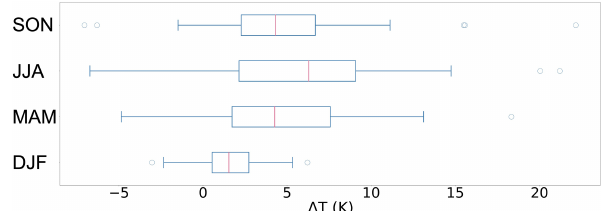
Figure 5. MERRA-2 2m temperature difference by season between the average temperature 24h before AR landfall and the average temperature 24h from AR landfall (post- minus pre-event) from MERRA-2 reanalysis over Thwaites Eastern Ice Shelf. Starting from the bottom, austral summer (December–January–February or DJF), fall (March–April–May or MAM), winter (June–July–August or JJA), and spring (September–October–November or SON). From left to right on each box plot: minimum, first quartile, median, third quartile, maximum. Outliers are represented as circles on the